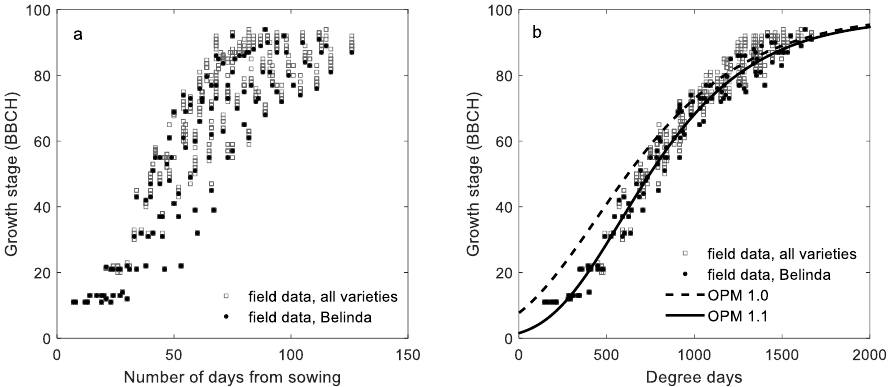
Figure 1. Observed growth stage (BBCH) data for six varieties versus ( a ) number of days from sowing and ( b ) degree days, including output data from the oat phenology model OPM 1.0 [8] and OPM 1.1 (Model 1 derived in this study). Observations on variety Belinda are marked in